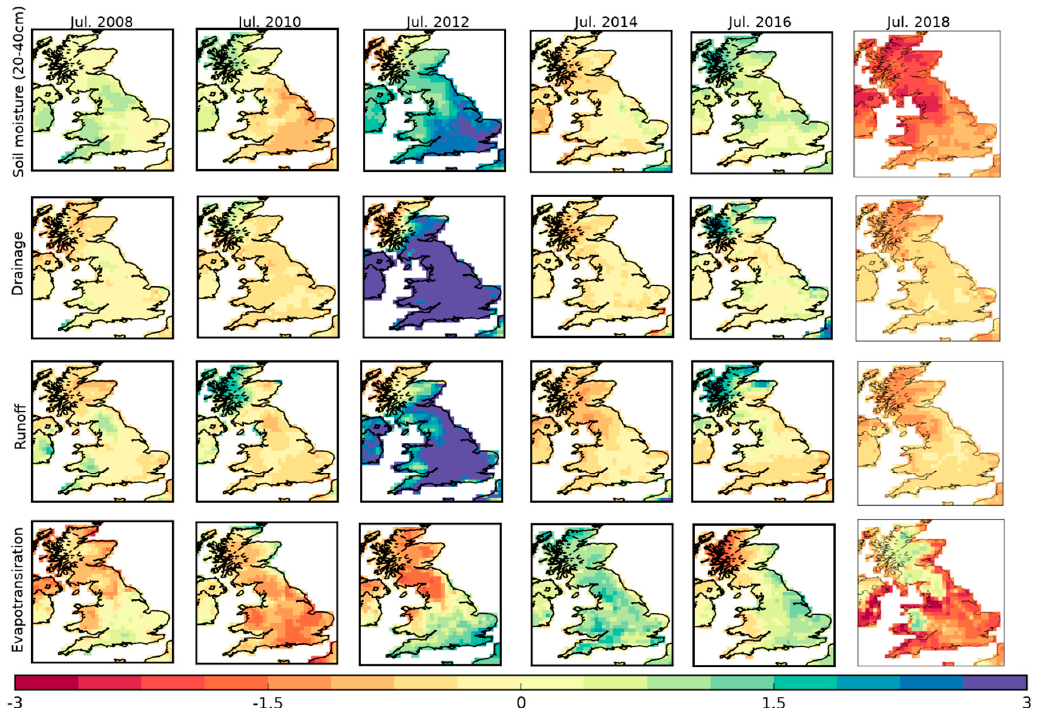
Figure 7. Maps of monthly anomalies (expressed in units of standard deviation) from LDAS-ERA5 analysis for July 2008, 2010, 2012, 2014, 2016 and 2018 with respect to the 2008–2018 period (from left to right) for the following variables: soil moisture form the fourth layer of soil (between 20 cm and 40 cm), drainage, runoff and evapotranspiration (from top to bottom).